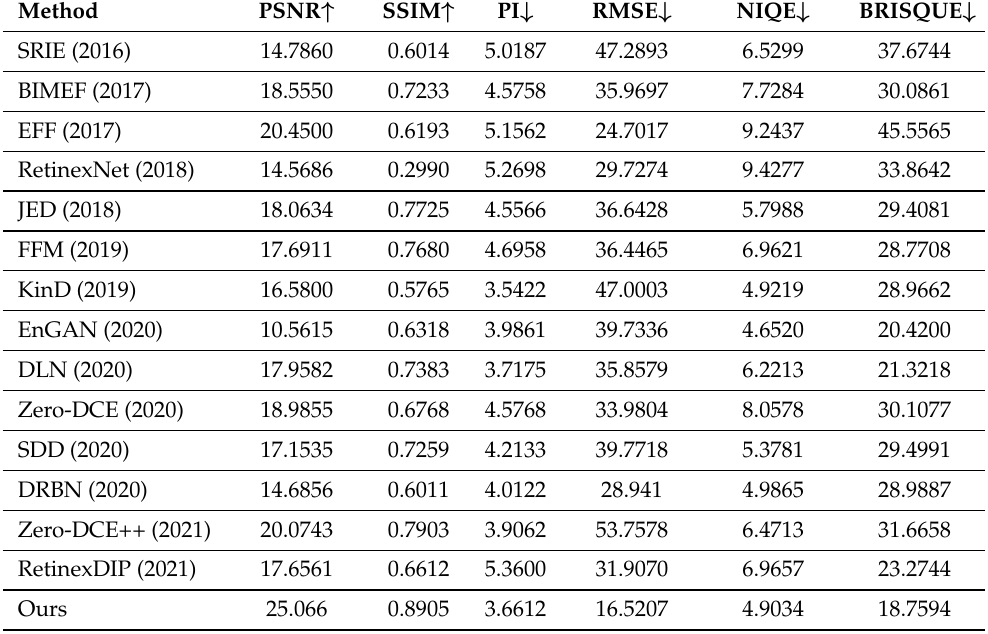
Table 4. Objective evaluation results of the six indicators PSNR, SSIM, PI, RMSE, NIQE, and RISQUE for the LOL [1]